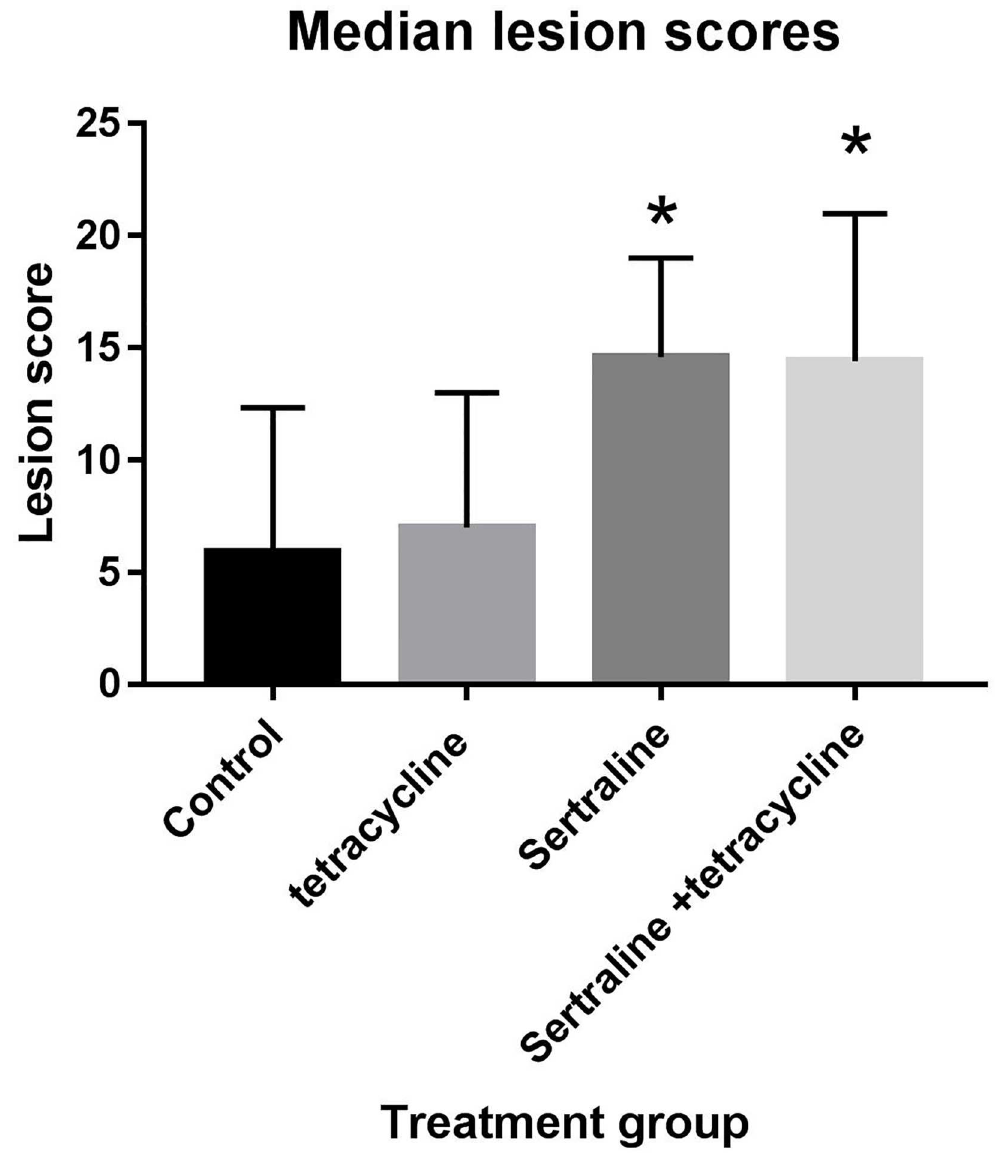
Fig 2. Lesion scores. Median lesionscore per chicken in the different treatment groups. Vertical bars indicate standarddeviation,and asterisk indicatedstatistical difference in lesion score comparedto the non-treatedcontrol